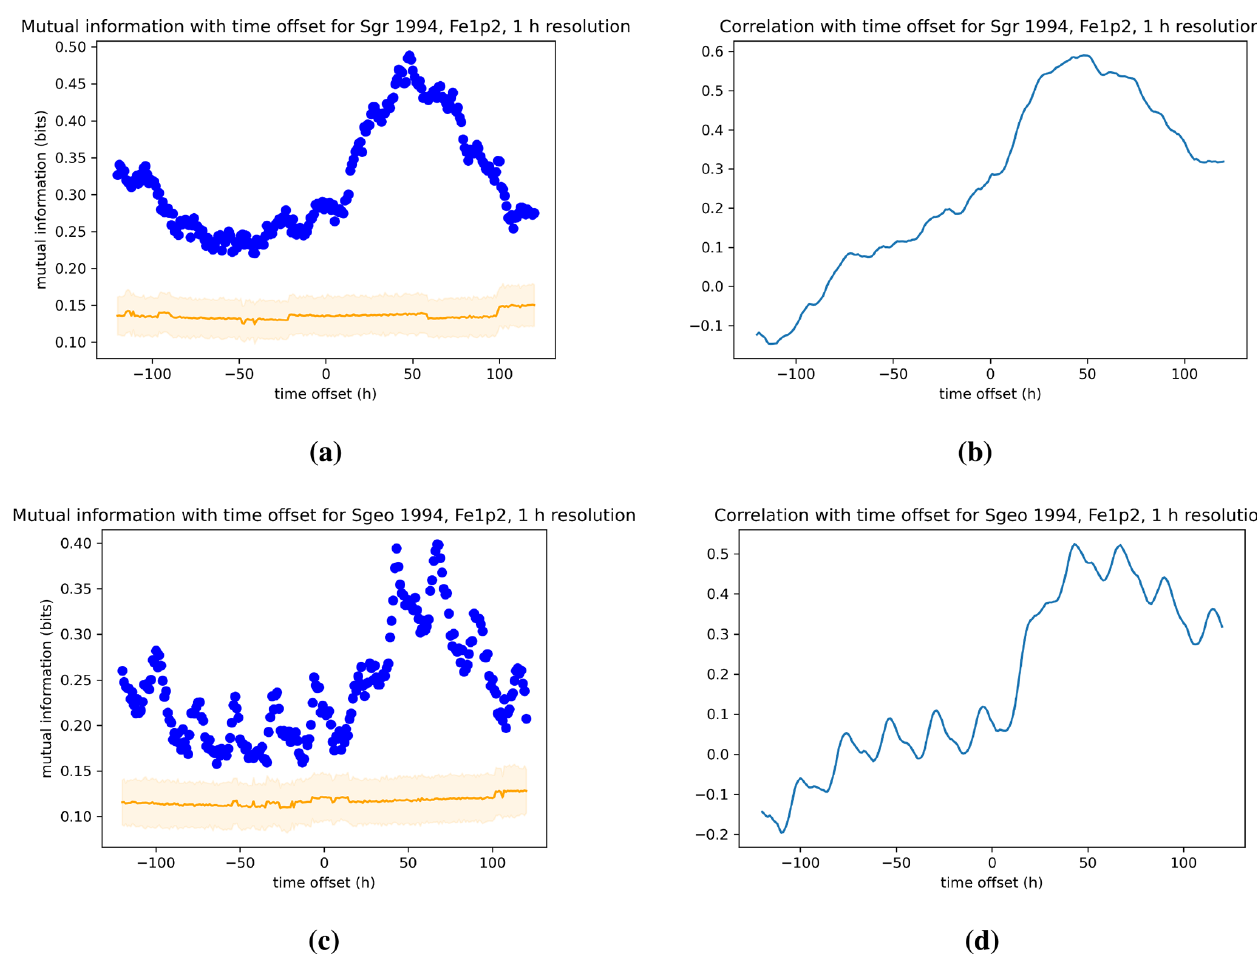
Figure 4. Dependence of the mutual information and Pearson correlation for ground (a, b) and geosynchronous (c, d) ULF power with the relativistic electron index F e 1 . 2 for the 1994 event. The data for both indices are processed with 1h resolution. See Sect. 4.1 for a description of the